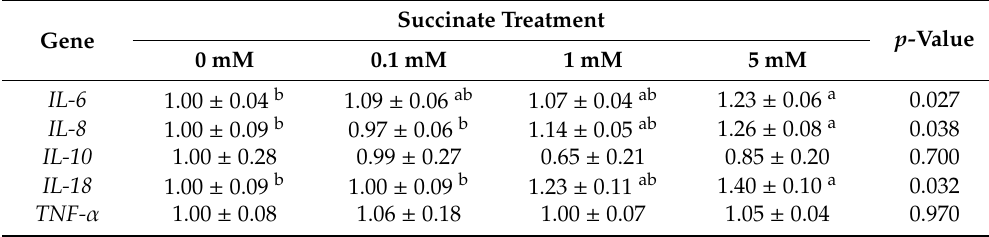
Table 7. E ff ects of sodium succinate at di ff erent levels on the mRNA levels of inflammatory cytokines in IPEC-J2